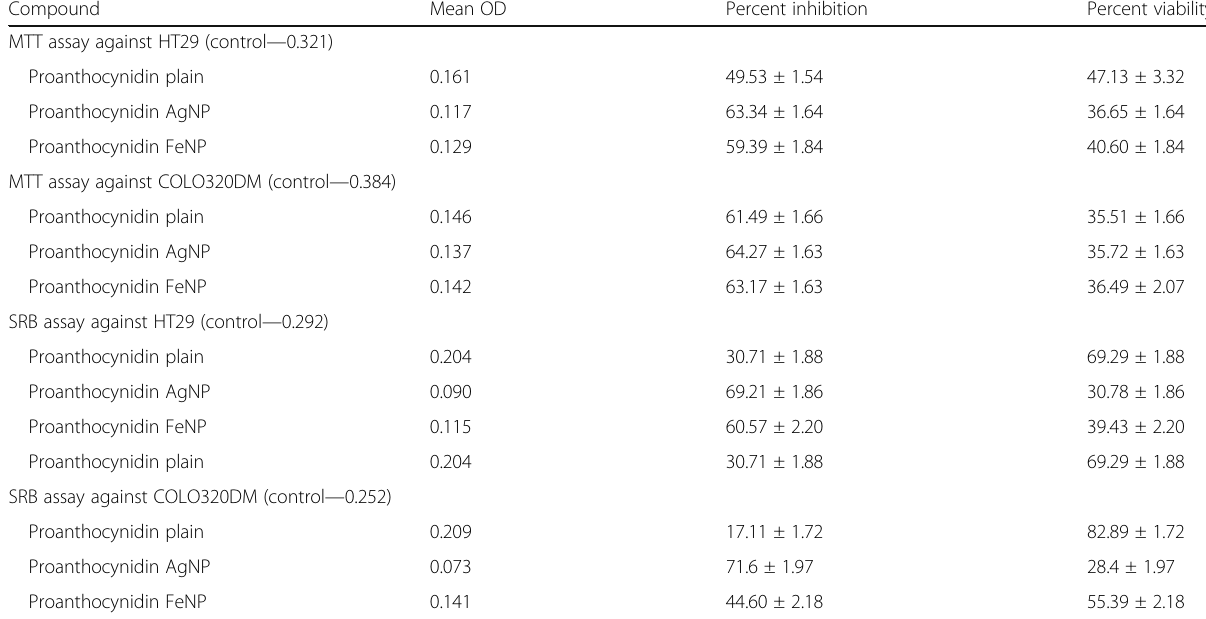
Table 2 Results of cytotoxicity of PAC, PACAgNPs, and PACFeNP by MTT and SRB assay using COLO320DM and HT29 cell lines Compound Mean OD Percent inhibition Percent